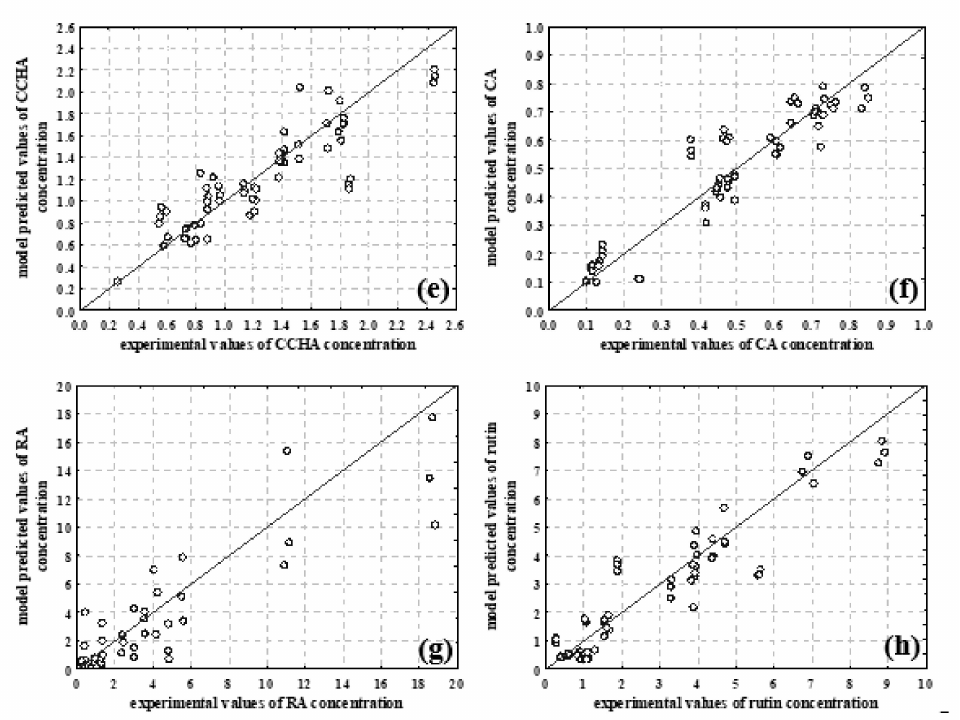
Figure 3. Comparison between experimental data and model predicted data for ( a ) TPC, ( b ) ABTS- measured antioxidant capacity, ( c ) DPPH-measured antioxidant capacity, ( d ) CHA—chlorogenic acid concentration, ( e ) cCHA—cryptochlorogenic acid concentration, ( f ) CA—caffeic acid concentration, ( g ) RA—rosmarinic acid concentration, and ( h ) rutin